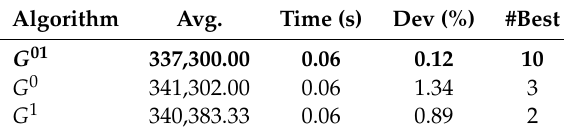
Table 1. Comparison among the three constructive procedures G 0 , G 1 , G 01 .